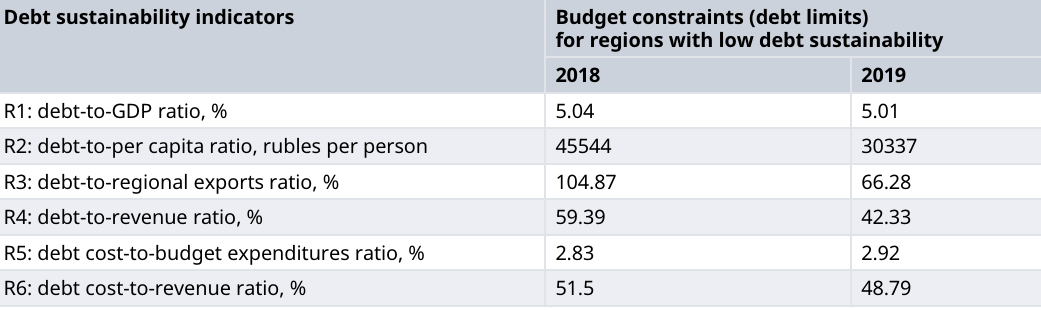
Table7.ResultsofthestudyofclustersbyregionsoftheNorthwesternFederalDistrict(NWFD)andvolumeof budget constraints (by the authors ’ calculations). Debt sustainability